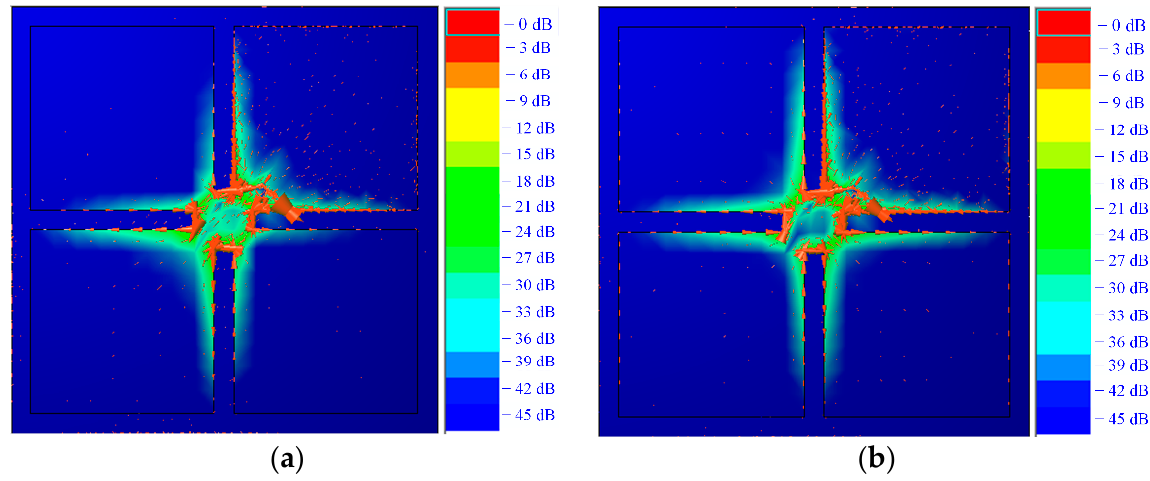
Figure 12. Current distribution for dual-band slotted square patch antenna at ( a ) 2.4 GHz and ( b ) 2.8 GHz.